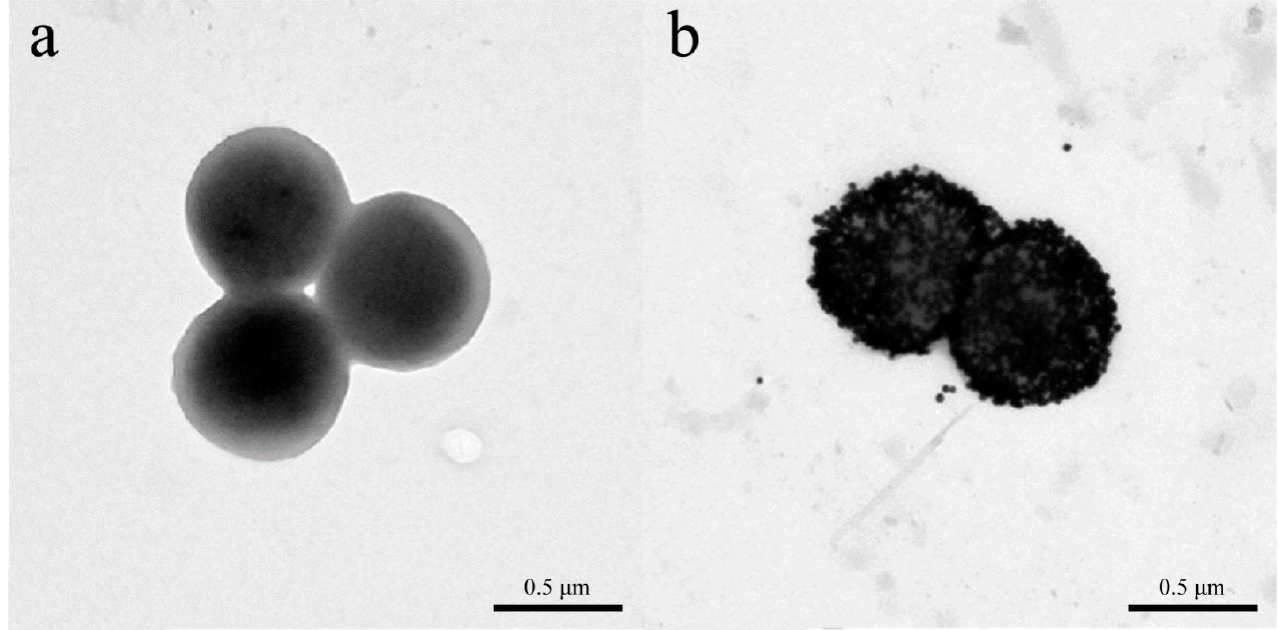
Figure 7. Transmission electron microscopic characterization of nanophage probe binding to Staphylococcus aureus . ( a ) S. aureus cells. ( b ) AuNP probe- S. aureus conjugates